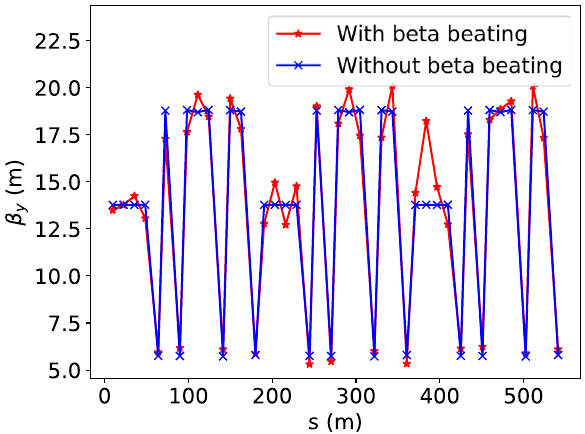
FIG. 6. Magnitudes of the complex entries of the block diagonal matrix D defined in Eq. (25), calculated for the case of ignoring the beta beating in the y plane of